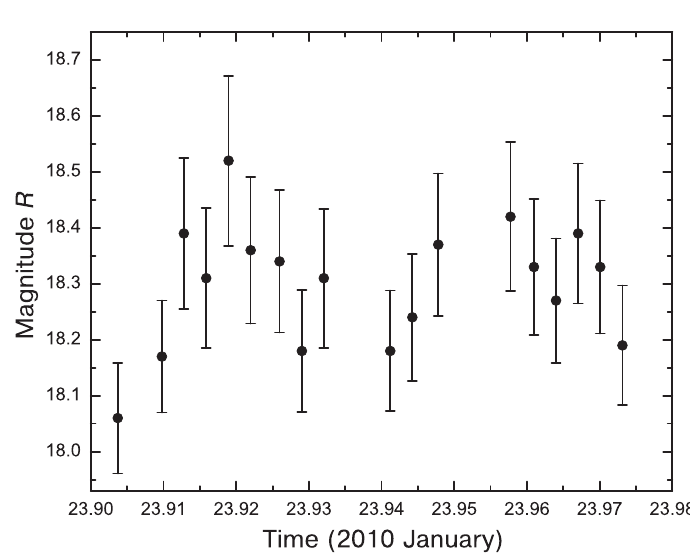
Fig. 3. Light curve of the asteroid 2010 BT3 with a period of 54